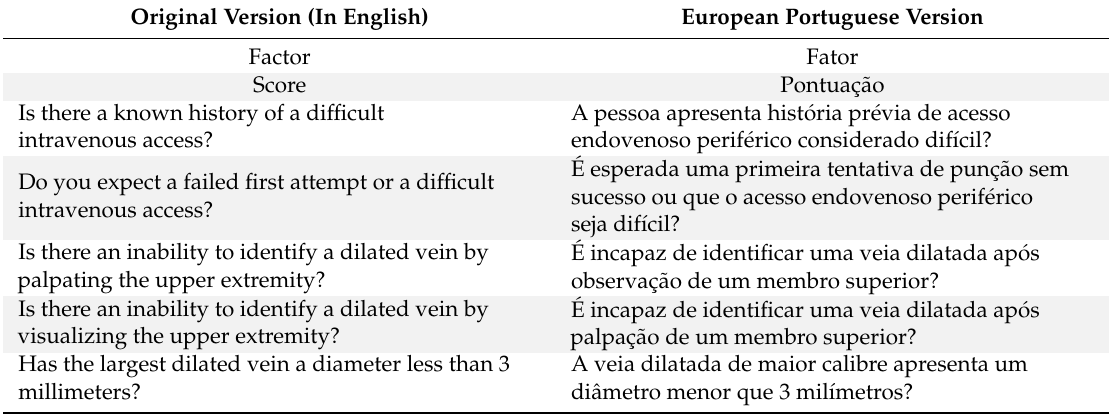
Table 1. The original and proposed version of the Modified A-DIVA scale (escala A-DIVA Modificada in European